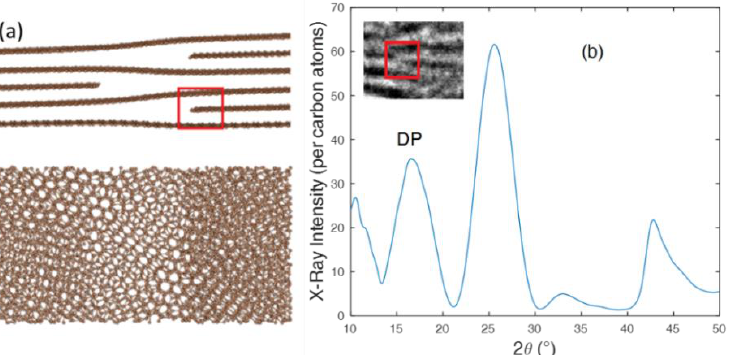
Figure 2. ( a ) Modelled dislocation showing an example of such a defect. ( b ) Simulated diffraction pattern profile obtained from the framed area in the atomistic model in ( a ), with an inset of a corresponding lattice fringe TEM image observed in a defective carbon.